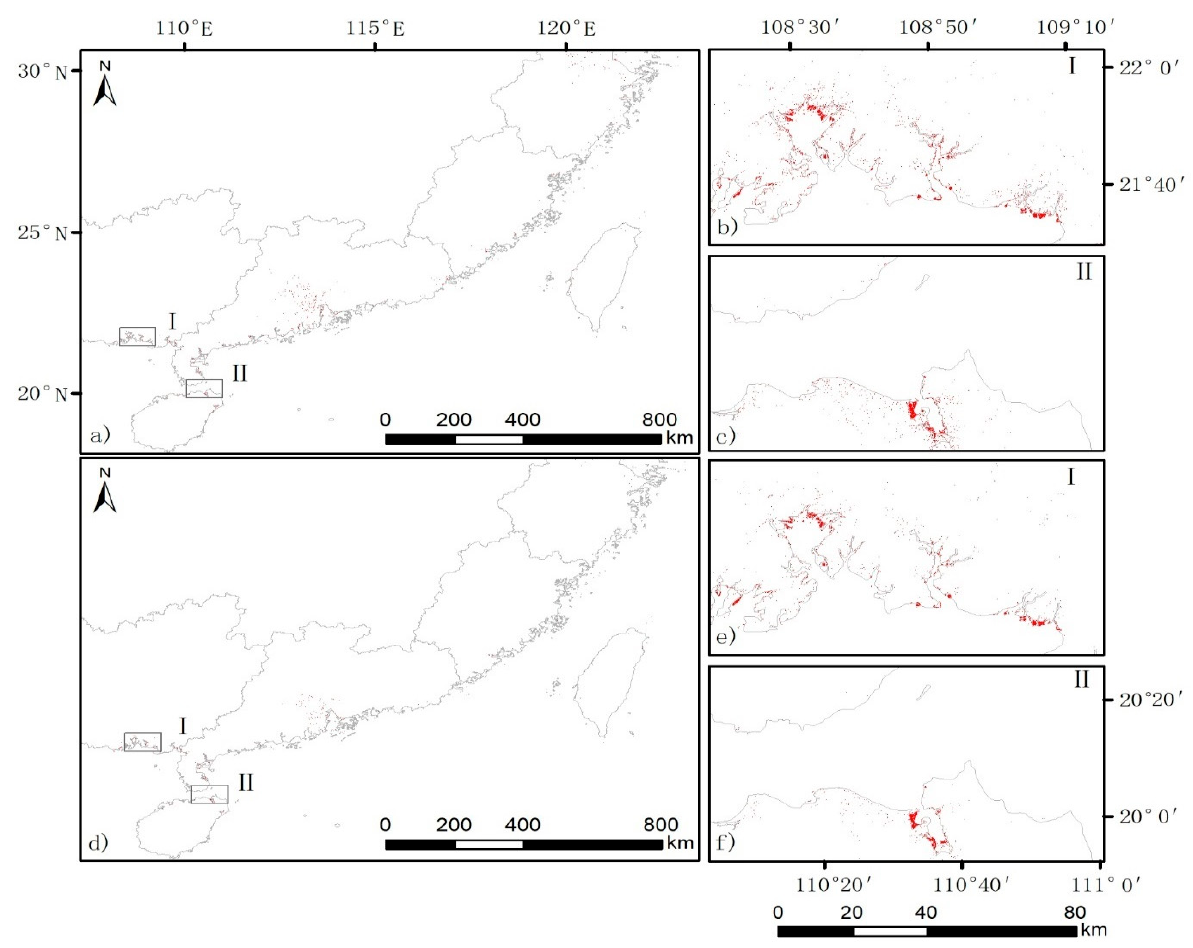
Figure 7. Mangrove classification results in China in 2018 from the two classification schemes: ( a ) the standard scheme and ( d ) the new scheme in the second experiment. The zoomed-in figures ( b – f ), share the same scale bar.